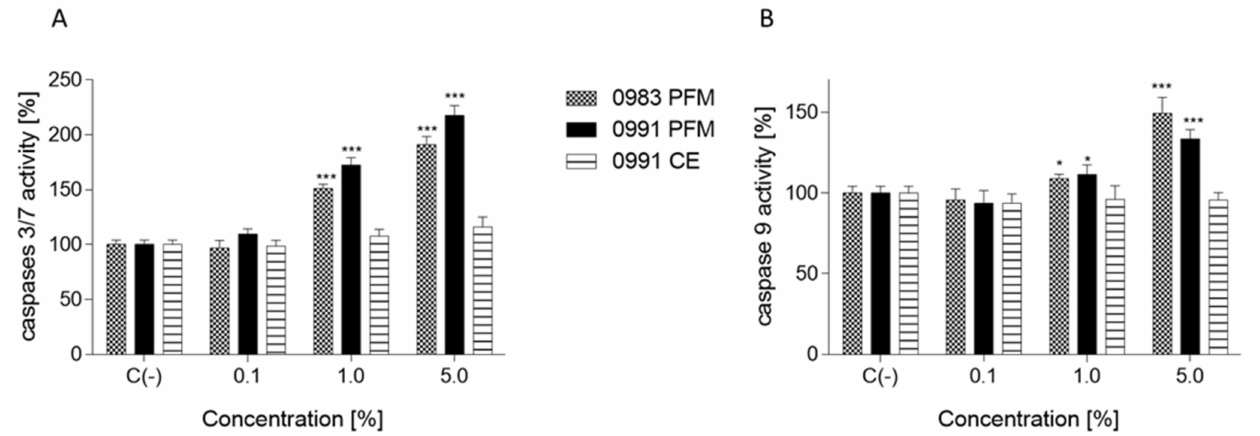
Figure 6. The influence of selected post-fermentation media (PFM) or cell extracts (CEs) on the activation of caspases 3/7 ( A ) and caspase 9 ( B ) in Caco-2 cells after 24 h incubation; values are means ± SD, n ≥ 4; statistical significance was calculated versus control cells (untreated), * p ≤ 0.05, *** p ≤ 0.001.